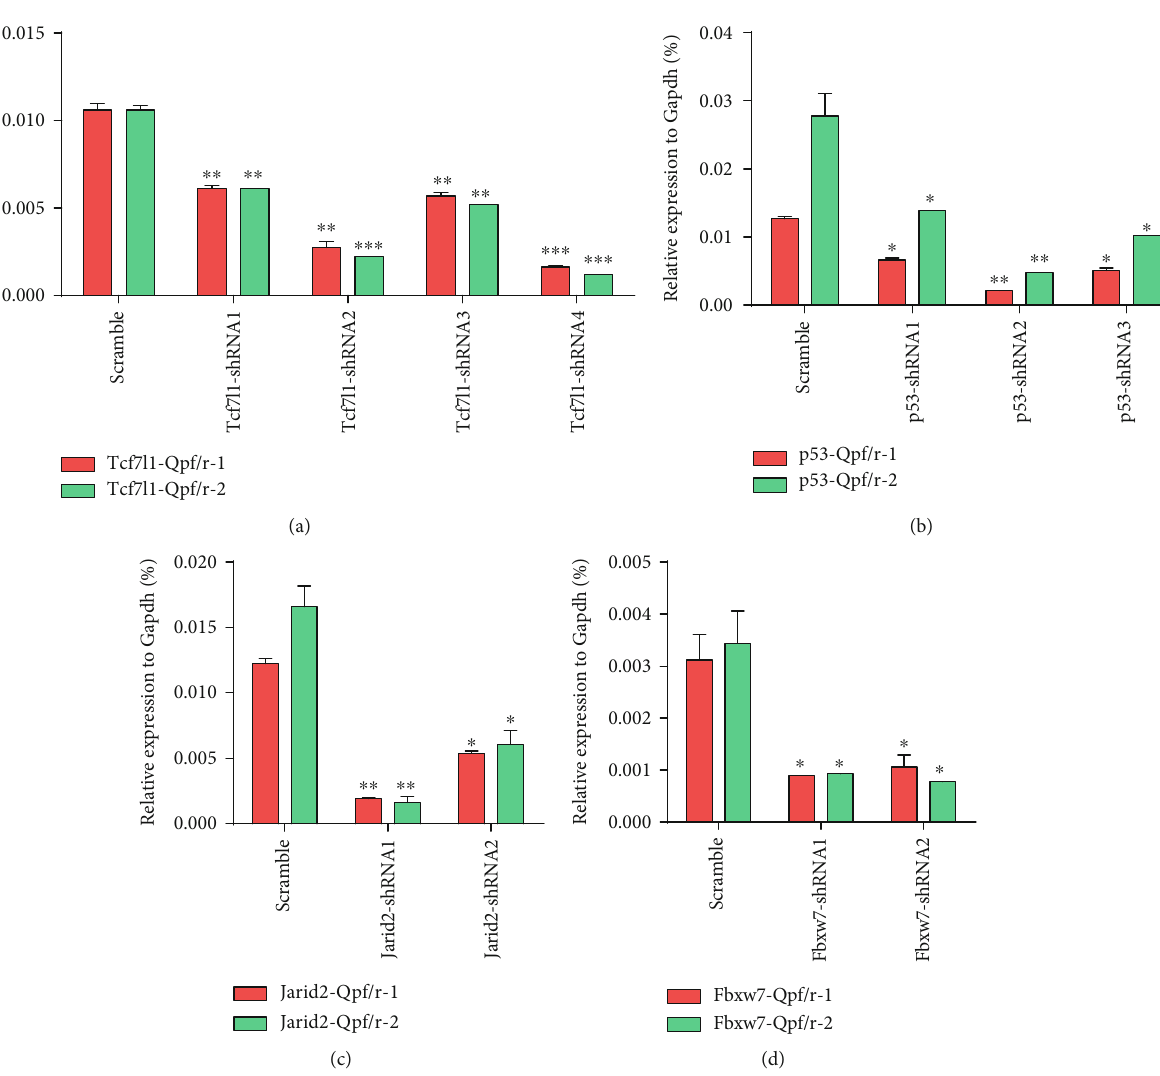
Figure 6: The knockdown e ffi ciency of shRNAs targeting the four candidates: (a) Tcf7l1 , (b) p53 , (c) Jarid2 , and (d) Fbxw7. The error bar represents standard error, ∗ P < 0 : 05 , ∗∗ P < 0 : 01 , ∗∗∗ P < 0 : 001 vs.